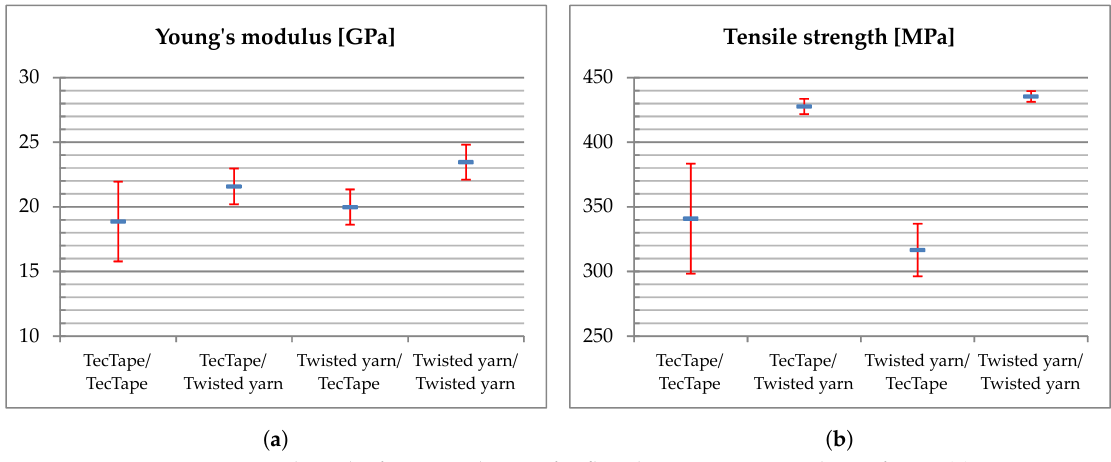
Figure 13. Experimental results from tensile tests for flat plate specimens with CI of 95%: ( a ) Young’s modulus. ( b ) Tensile strength.